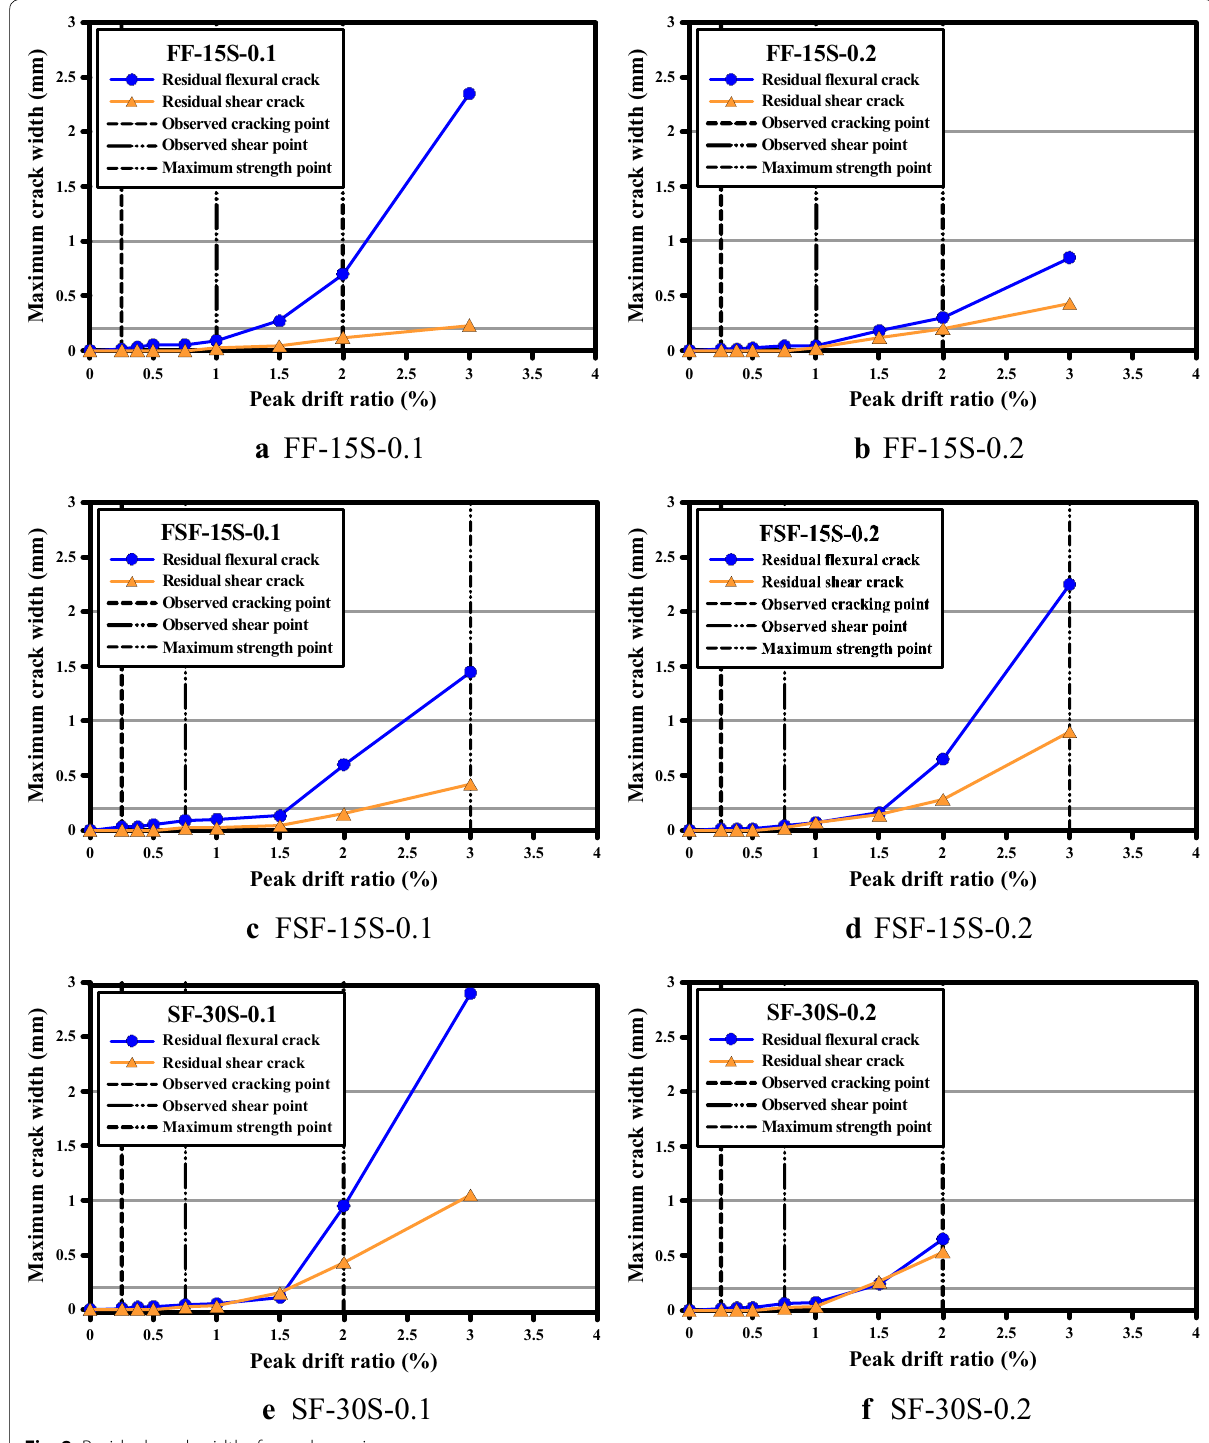
Fig. 8 Residual crack widths for each